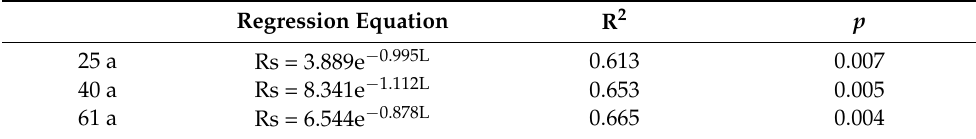
Table A2. Univariate models of the soil respiration rate against the litter input one month ago in different-aged Betula platuphylla forests of permafrost region, Northeast China at the monthly